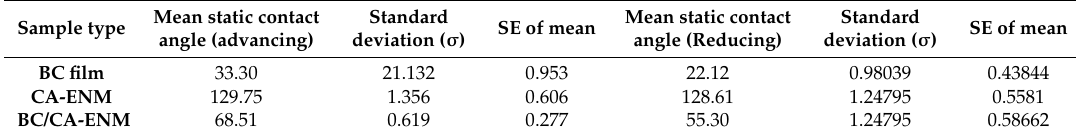
Figure 8. Contact angle measurement for pure BC films, BC/CA-ENM hybrid mats, and CA-ENMs. Table 1. Statistical results for water contact angle (advancing/reducing).